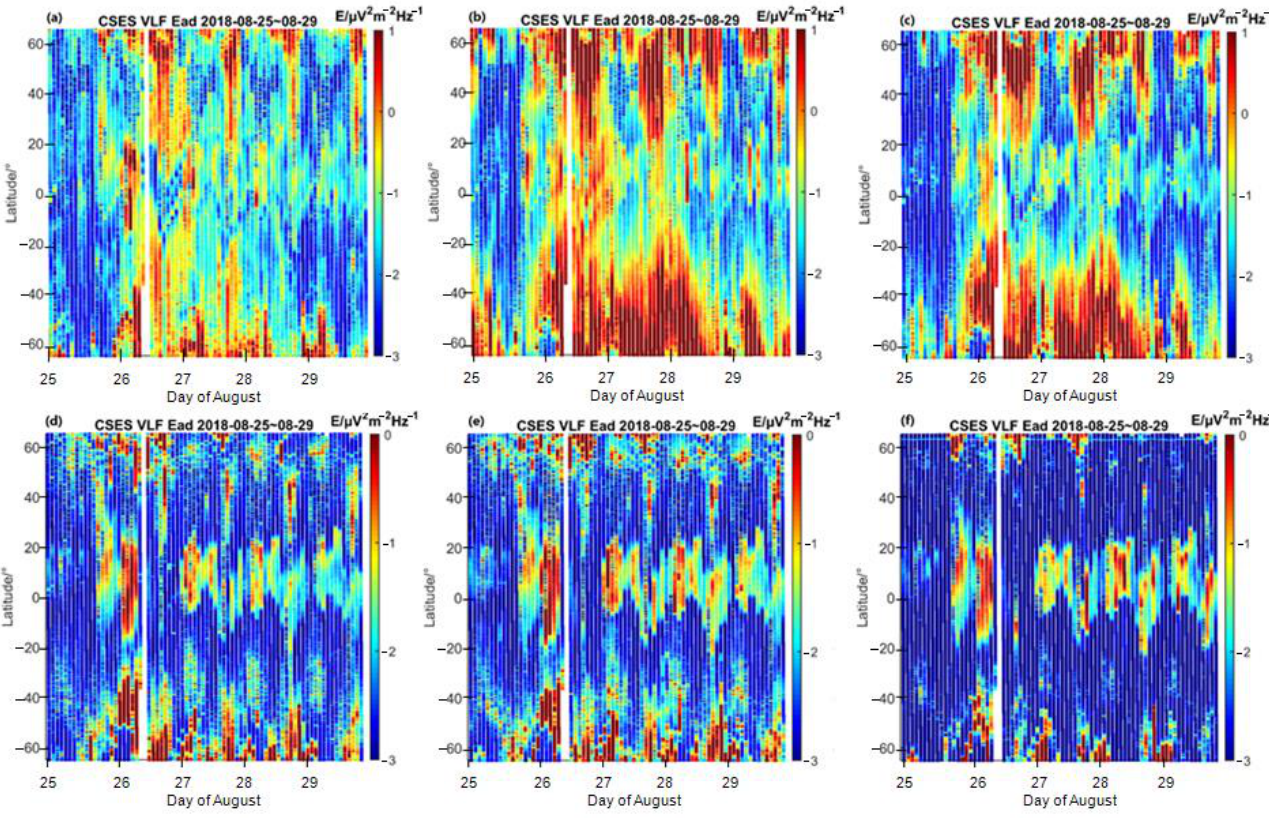
Figure 2. The electric spectrum time series with geographic latitude at 6 frequency bands (( a ): 225 Hz; ( b ): 725 Hz; ( c ): 1125 Hz; ( d ): 5000 Hz; ( e ): 7500 Hz; ( f ): 13,500 Hz) in local daytime from 25 to 29 August in 2018.